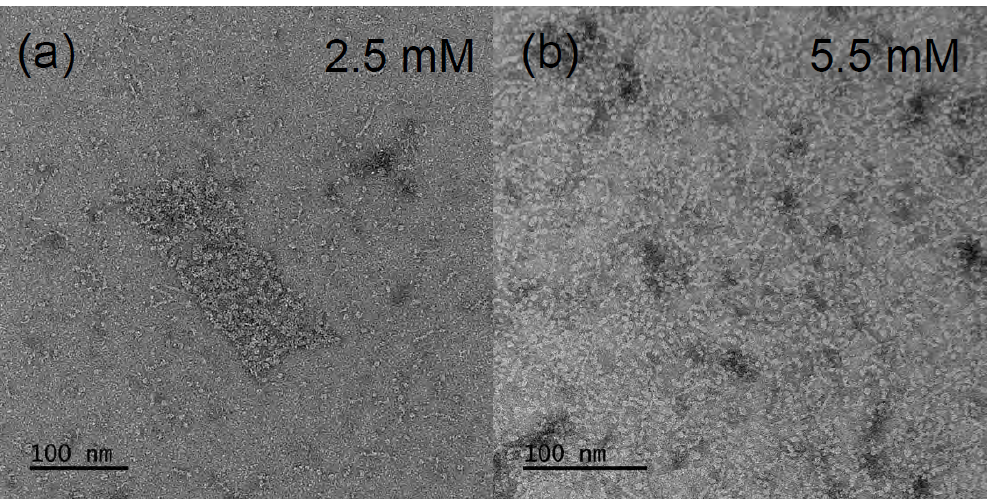
Figure 3. TEM images of dry and stained β -aescin micelles. The concentrations of the solutions are ( a ) 2.5mM and ( b ) 5.5mM and were prepared at 6 ◦ C. Reproduced with permission from Dargel et al. [29], Colloids Interfaces; published by MDPI,